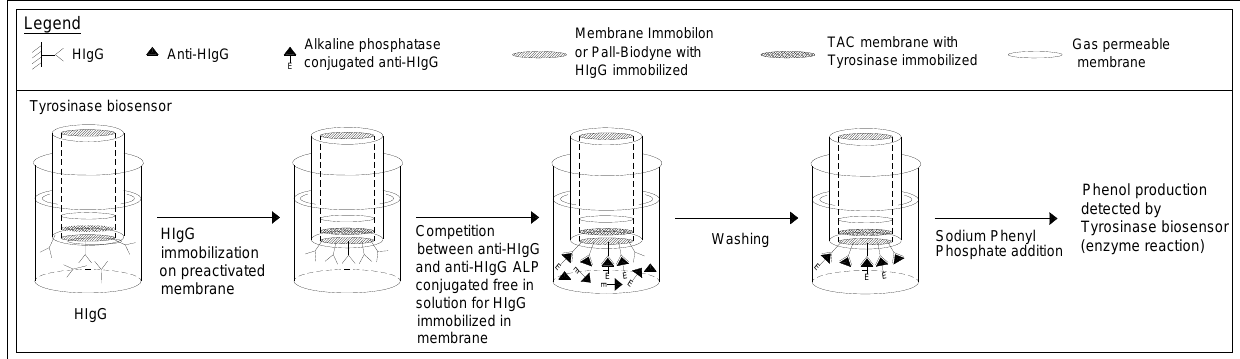
Figure 2. Determination of antibody (Anti-HIgG) by new immunosensor using tyrosinase enzyme electrode as transducer. Test geometry: competition for HIgG immobilized in membrane, between Anti-HIgG alkaline phosphatase conjugated and non-conjugated, both free in